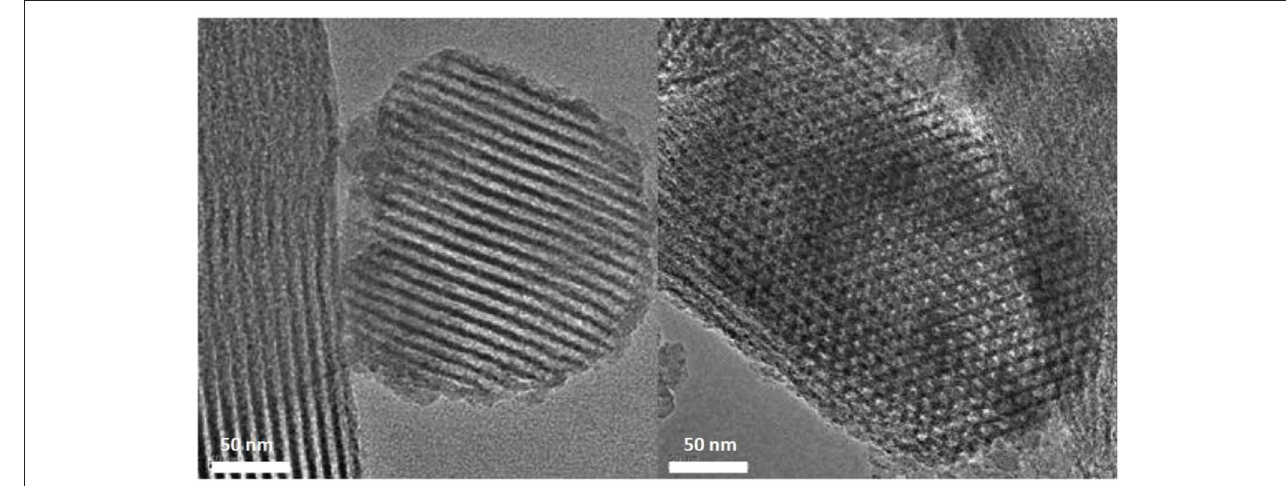
FIGURE 3 | TEM images of sample of SBA-Ar.